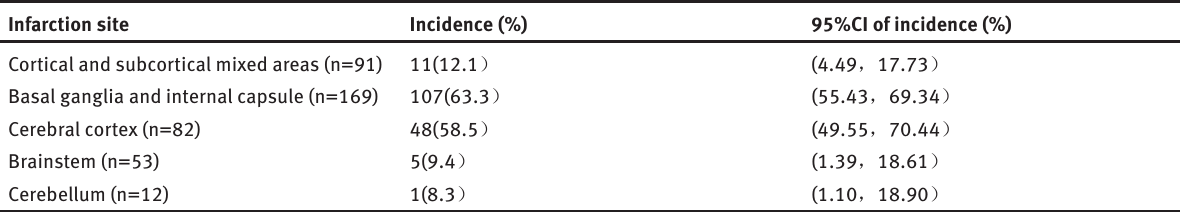
Table 1: Relationship between upper limb spasticity and cerebral infarction site Infarction site